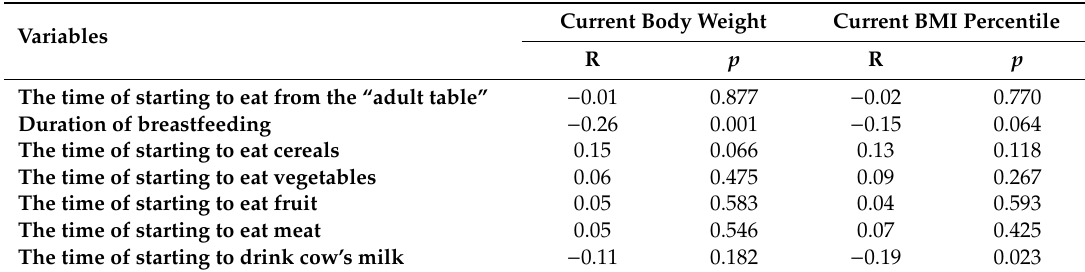
Table 3. Correlation of the time of introducing individual food products and duration of breastfeeding with current weight.